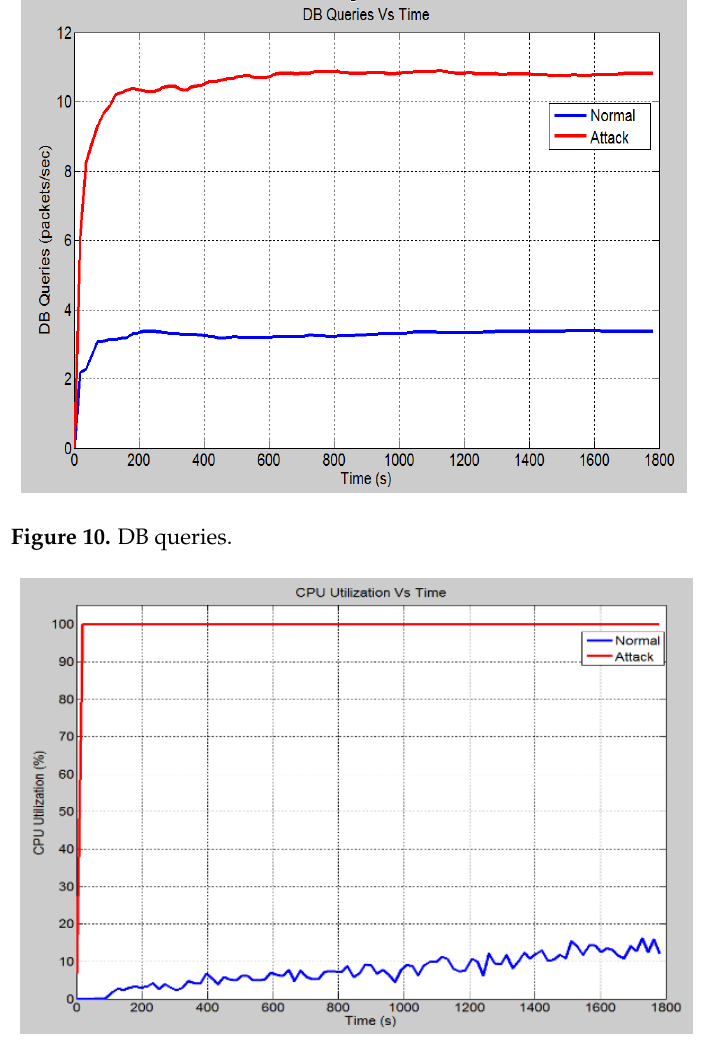
Figure 11. CPU utilization rate